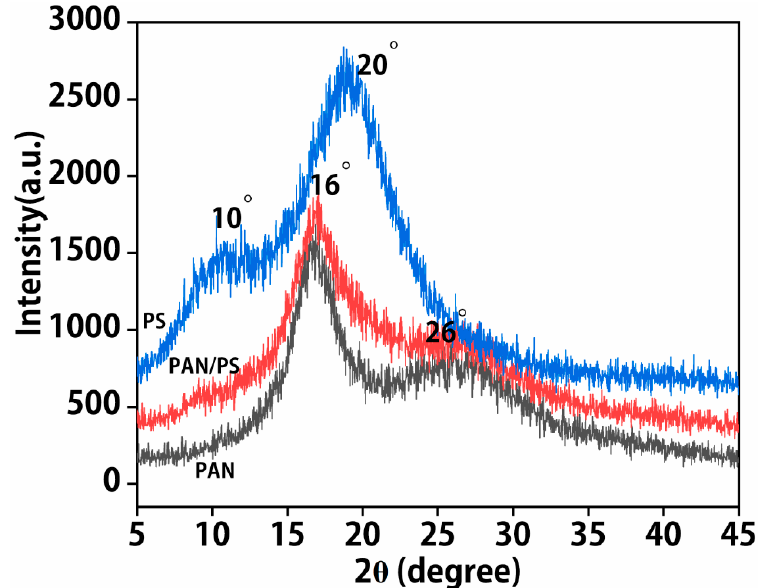
Figure 4. XRD patterns of PAN nanofibers, PS nanofibers, and PAN/PS composite nanofibers.